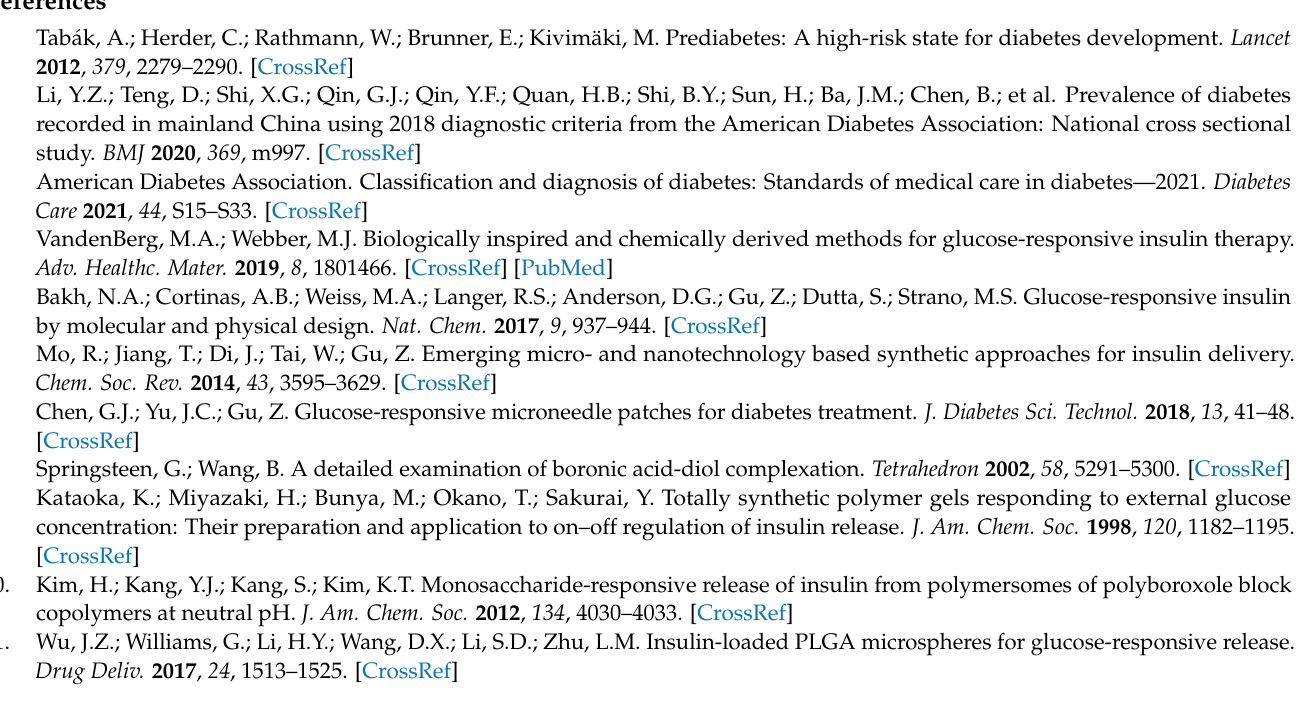
and CAT, Figure S2: ESI-MS spectrum of EP, Figure S3: ESI-MS spectrum of BP, Figure S4: ESI-MS spectrum of FBP, Figure S5: ESI-MS spectrum of OP, Figure S6: ESI-MS spectrum of FOP, Figure S7: 1 H NMR spectrum of BP (300 MHz in CHCl 1 H NMR spectrum of FBP (300 MHz in 3 ), Figure S8: CHCl 3 ), Figure S9: 1 H NMR spectrum of OP (300 MHz in CHCl 3 ), Figure S10: 1 H NMR spectrum of FOP (300 MHz in CHCl 3 ), Figure S11: Particle size changes in MVL(F+E+I) in PBS (pH 7.4) with different glucose concentrations, Figure S12: In vitro accumulated insulin release from MVL(E+I) in PBS (pH 7.4) with different glucose concentrations, Figure S13: Docking study of the interaction of DOPC with GOx, Figure S14: Docking study of the interaction of DPPG with GOx, Figure S15: Docking study of the interaction of FOP with GOx, Figure S16: Docking study of the interaction of cholesterol with GOx, Figure S17: Blood glucose and serum insulin levels of diabetic rats treated